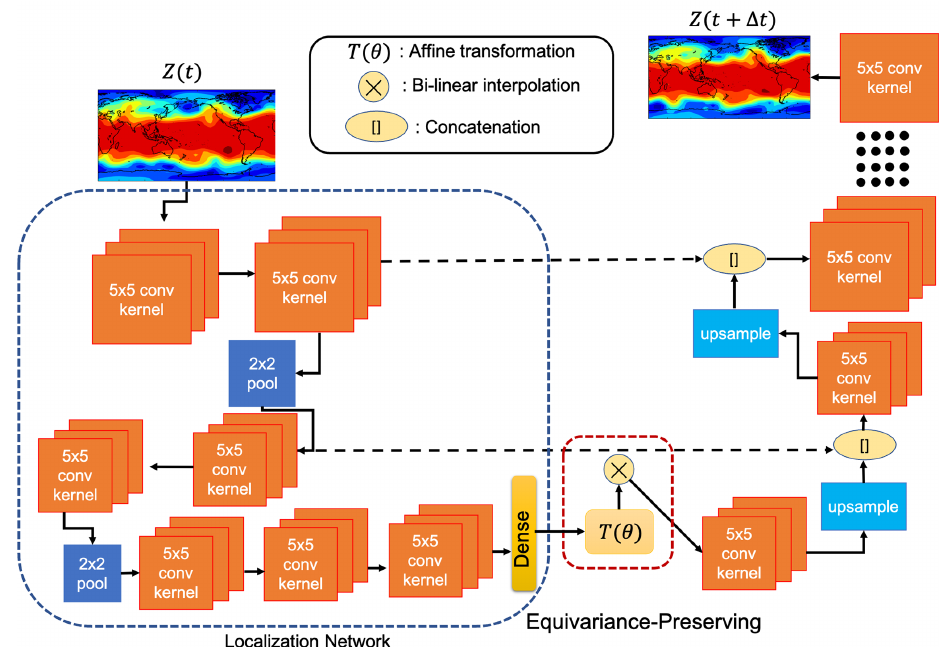
Figure 1. A schematic of the architecture of U-STNx. The architecture captures rotation and scaling transformations between the input to the latent space and the decoded output owing to the spatial transformer module implemented through the affine transformation, T (θ) , along with the differentiable bilinear interpolation kernel. The network integrates Z(t) to Z(t + (cid:49)t) . The size of the bottleneck layer is 8 × 16. Note that the schematic does not show the exact number of layers or number of filters used in U-STNx and U-NETx for the sake of clarity. The information on the number of layers and number of filters along with the activation function used is shown in Table